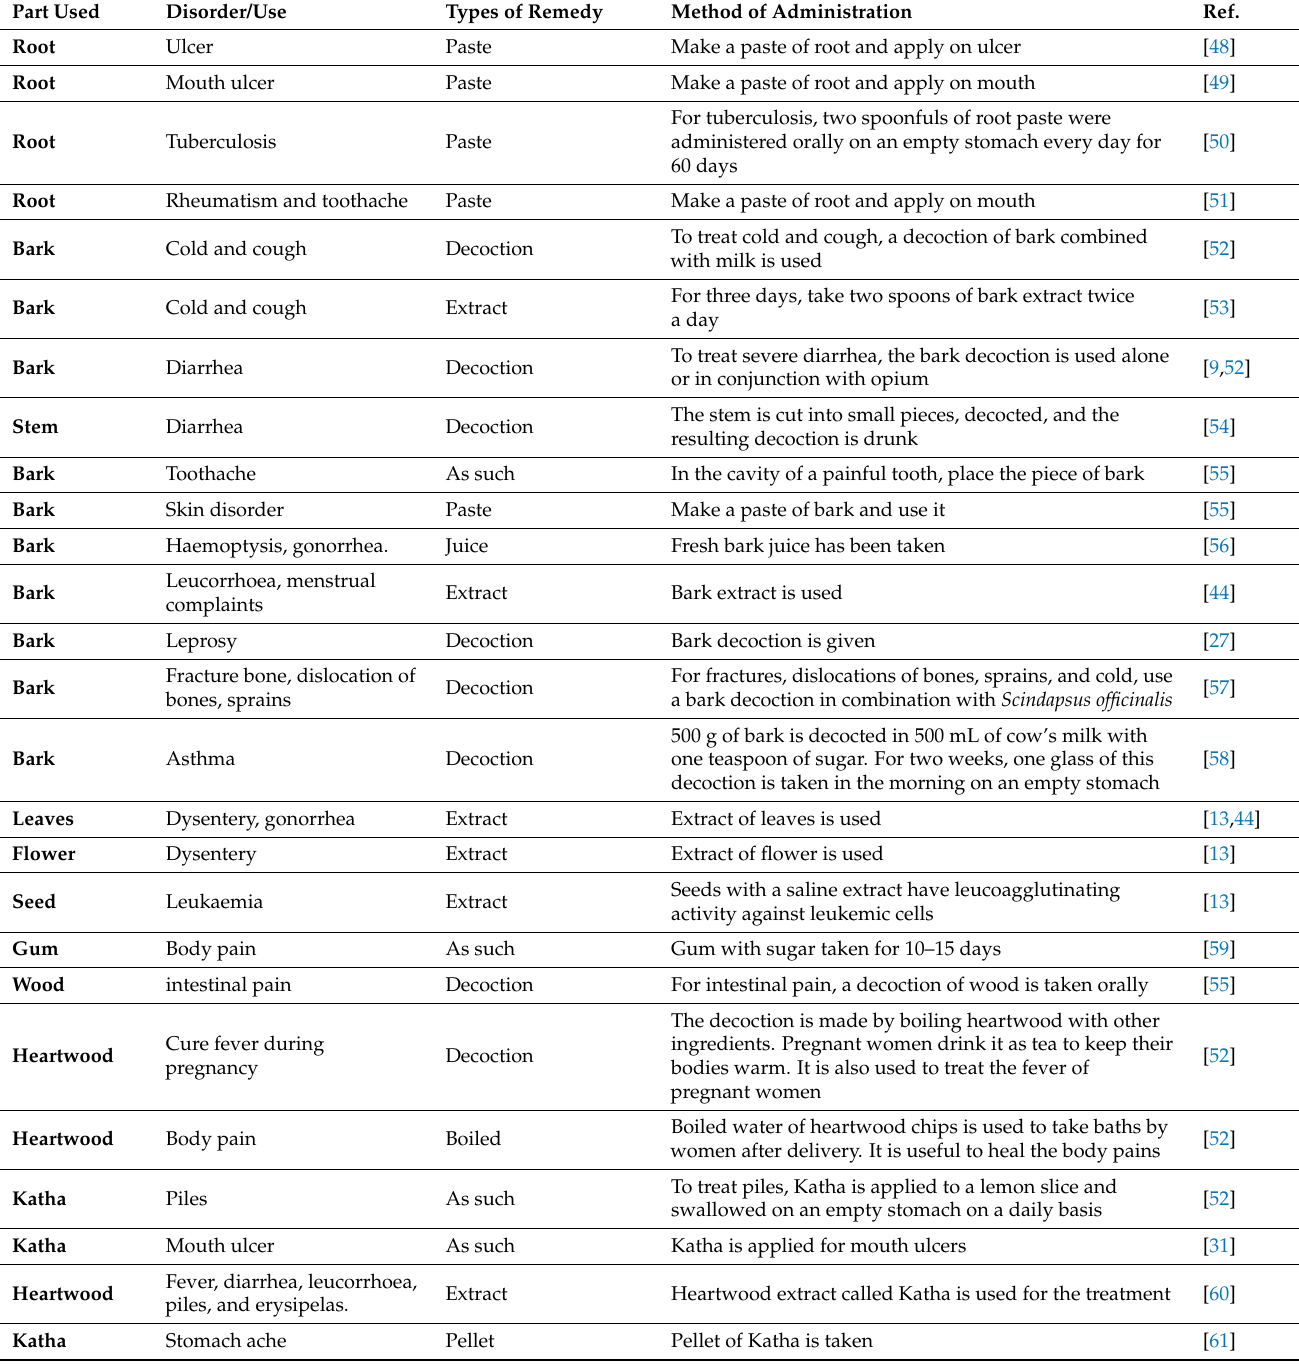
Table 3. Traditional uses of Acacia catechu